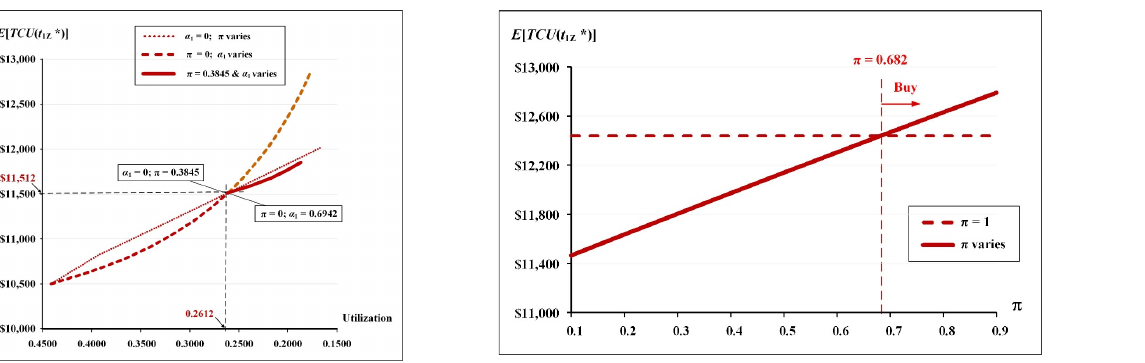
Fig. 17. Managerial insights concerning an Fig. 18. The critical outsourcing proportion π on ‘make-or- buy’